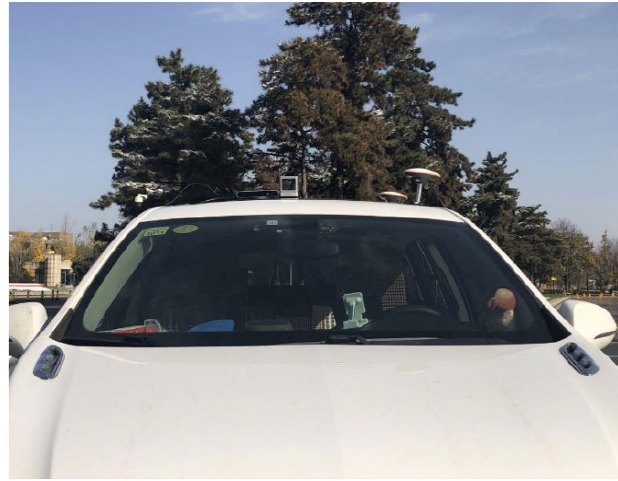
Figure 9. The experimental equipment was completed by loading LIVOX LiDAR, a camera and RTK